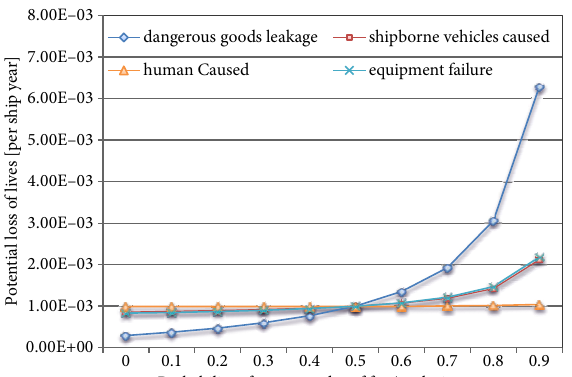
Fig. 7. Sensitivity analysis of hazards over the probability of fire/explosion